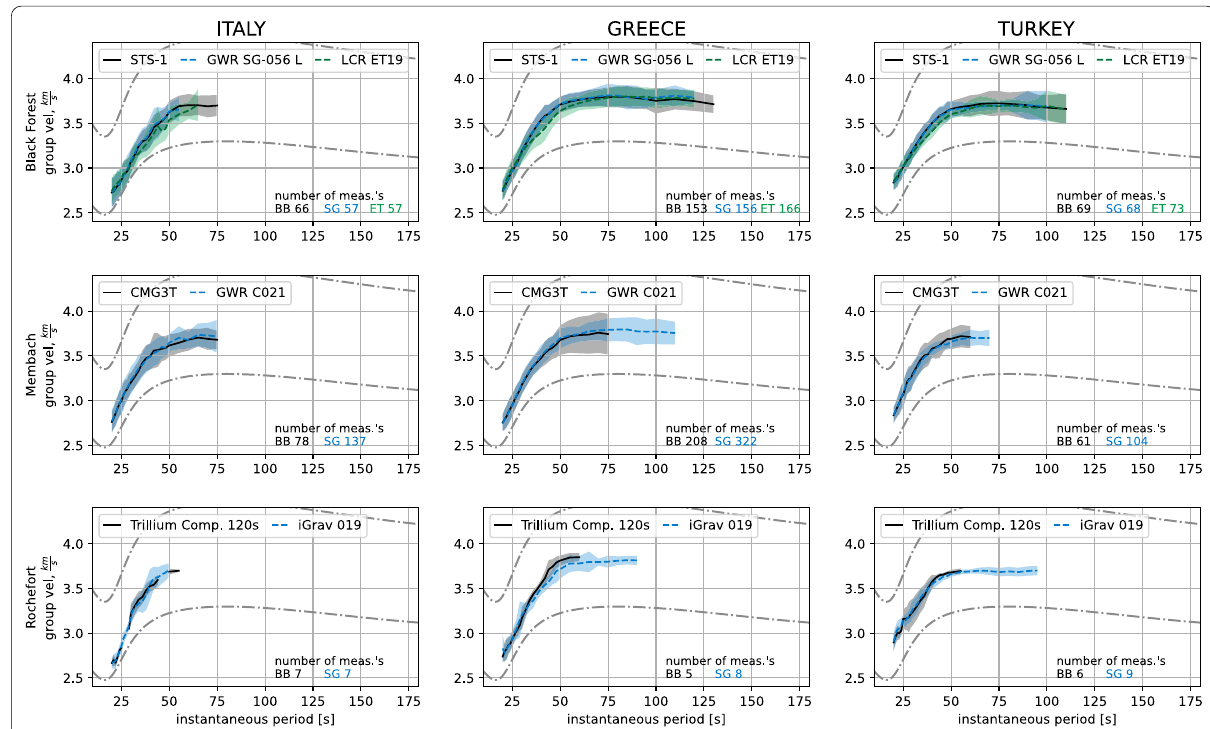
Fig. 5 Averaged dispersion curves of group‑velocity of fundamental‑mode Rayleigh waves (solid and dashed lines) with the standard deviation of individual measurements (shaded areas) and minimum and maximum value of the background model (dash‑dotted grey lines) for each instrument of the Black Forest, Membach and Rochefort stations calculated for the Italy, Greece and Western Turkey regions,